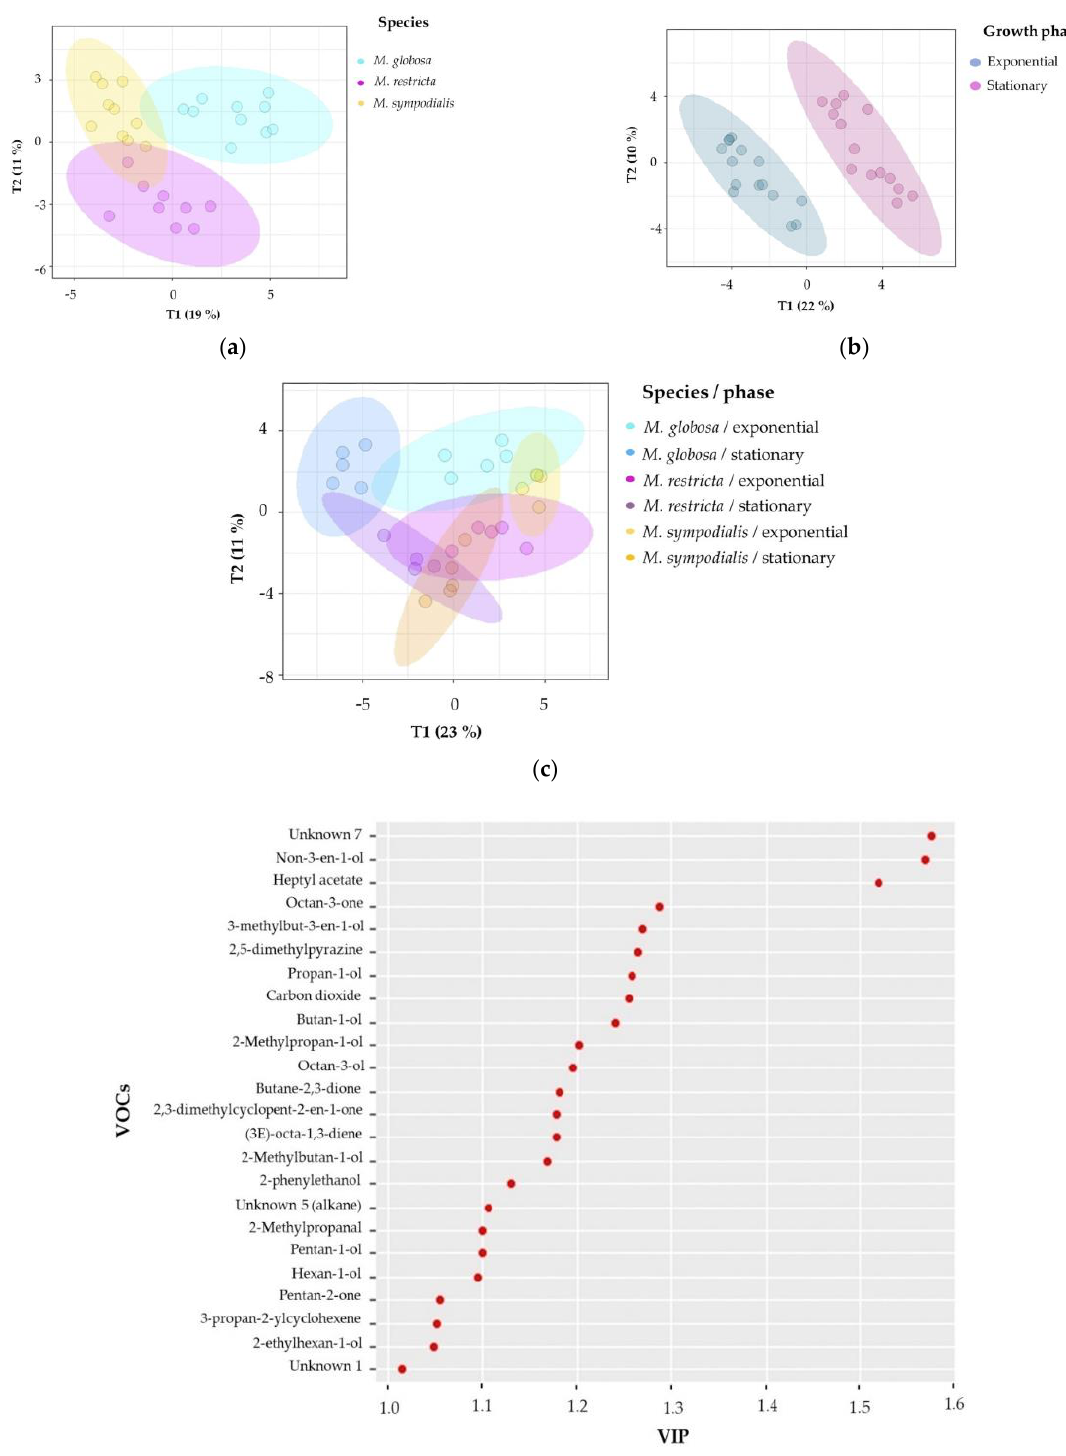
Figure 5. Projection of latent structures-discriminant analyses (PLS-DA) of the volatile profile for Malassezia species in two growth phases. ( a ) PLS-DA of the volatile profile discriminated by the species (Q2 = 0.798); ( b ) PLS-DA of the volatile profile discriminated by growth phases (Q2 = 0.877); ( c ) PLS-DA of the volatile profile discriminated by the species/growth phase (Q2 = 0.727); ( d ) Variable importance in projection (VIP) plot of the volatile profile discriminated by the species/growth phase. The ellipses in these plots are confidence intervals of 95% using a t -distribution.